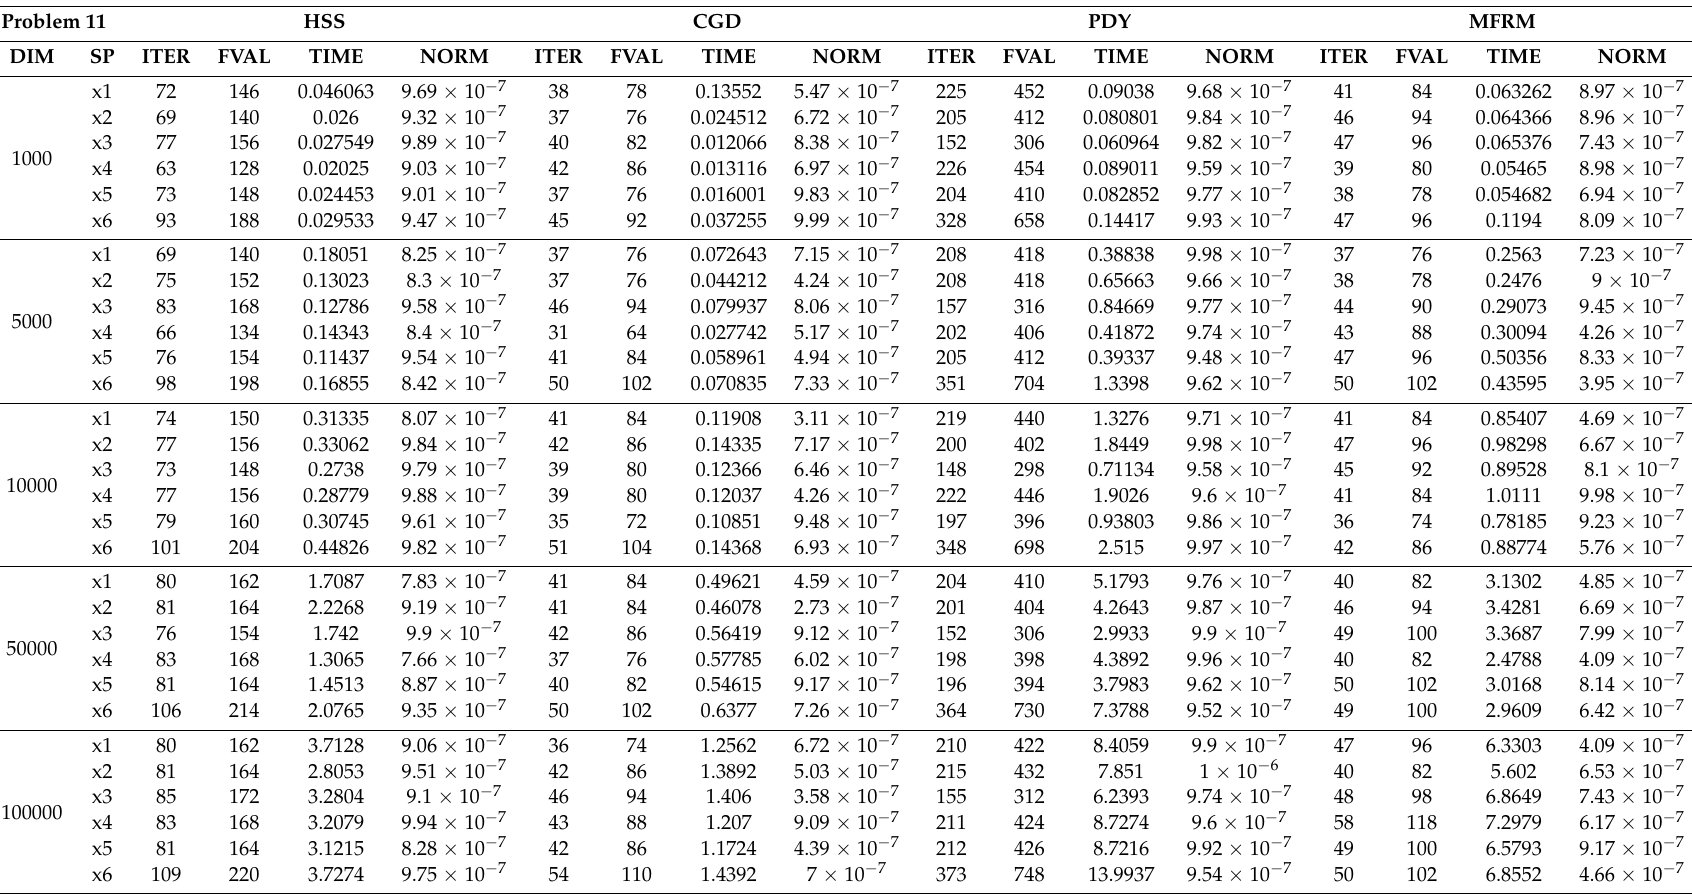
Table 10. Test results obtained by the four solvers for Problem